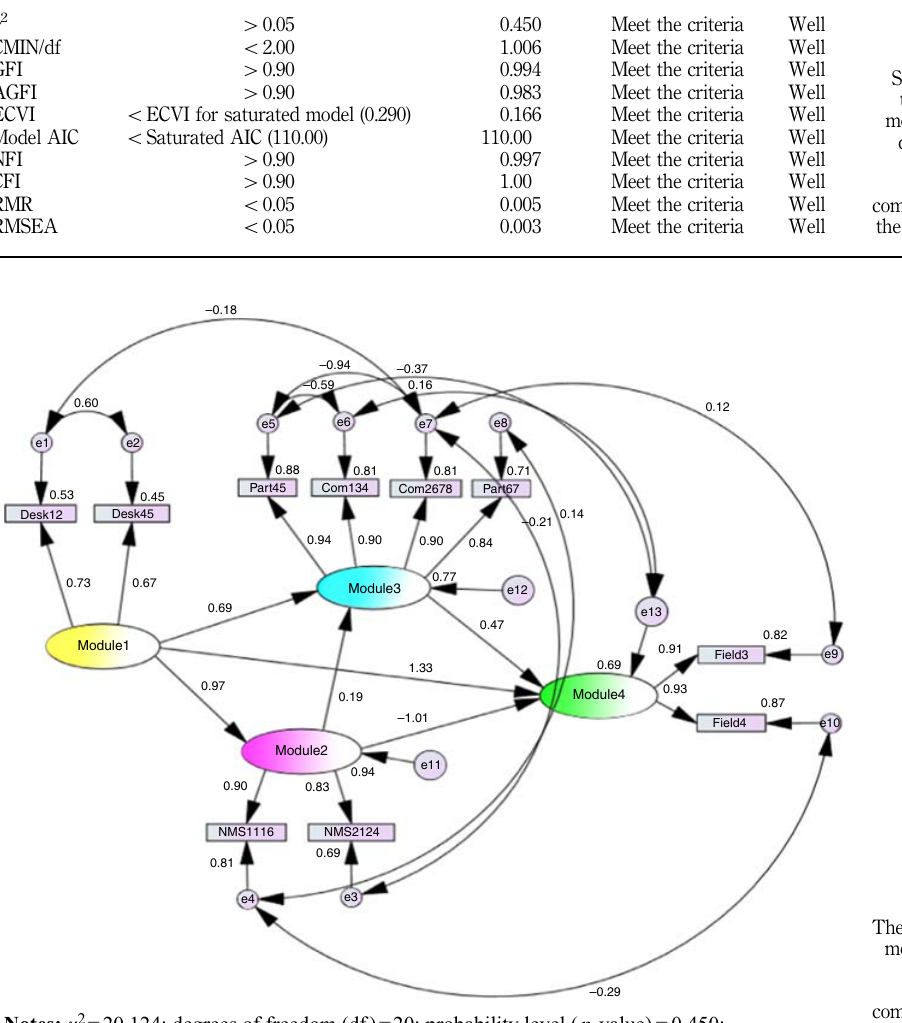
Table VI. Statistics measuring